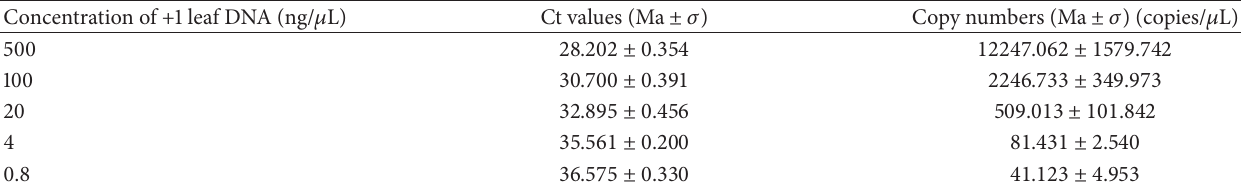
Table 1: Mean Ct values and copy numbers obtained by sensitivity test by TaqMan real-time PCR assay.